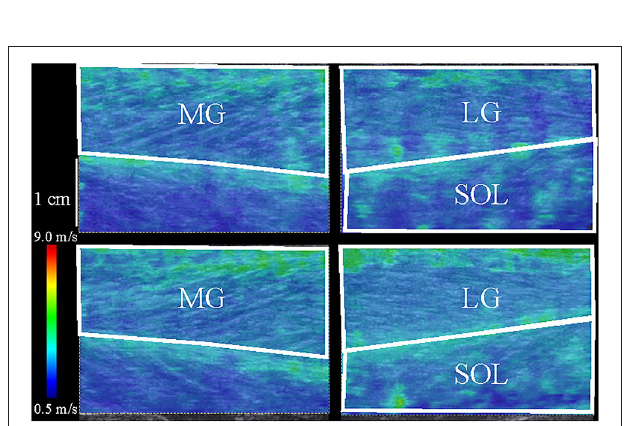
FIGURE 2 | Typical elastographic images of the medial and lateral gastrocnemius muscles (MG and LG) and the soleus muscle (SOL) before (upper) and after (lower) the fatiguing task. Shear wave ultrasound elastography generated color-coded images with a scale from blue (soft) to red (hard) depending on the magnitude of shear wave propagation